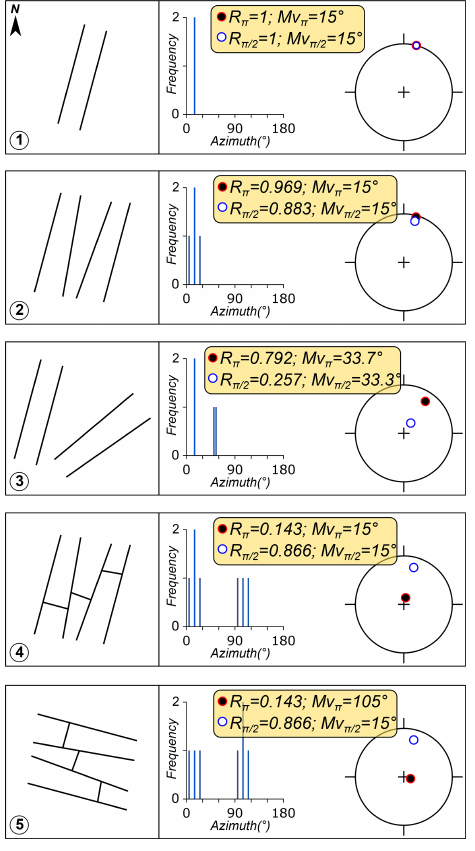
Figure 4. Examples of joint patterns and the resulting Mv and R parameters calculated for the π and π/ 2 periods. For the five exam- ples, we show the map view of the joints, the azimuthal frequency, and the sin–cos coordinates of the resulting values of Mv and R . Note that the distance from the center is proportional to R